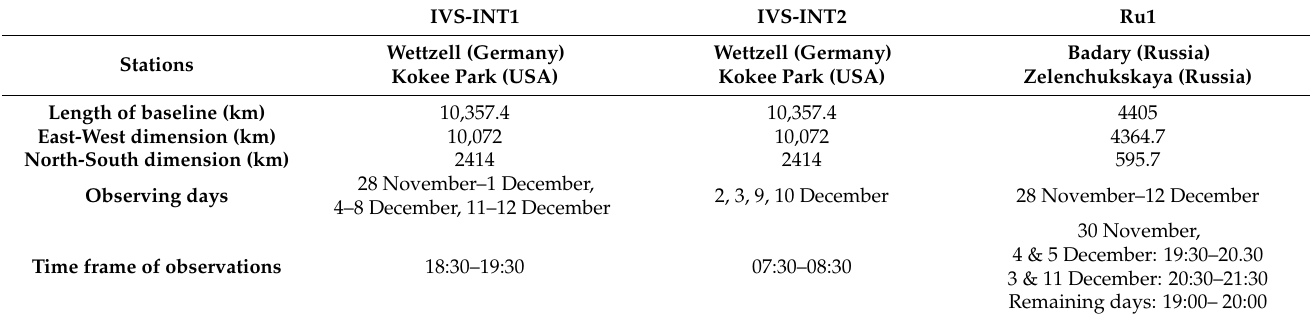
Table 2. Overview of Intensive sessions during CONT17.